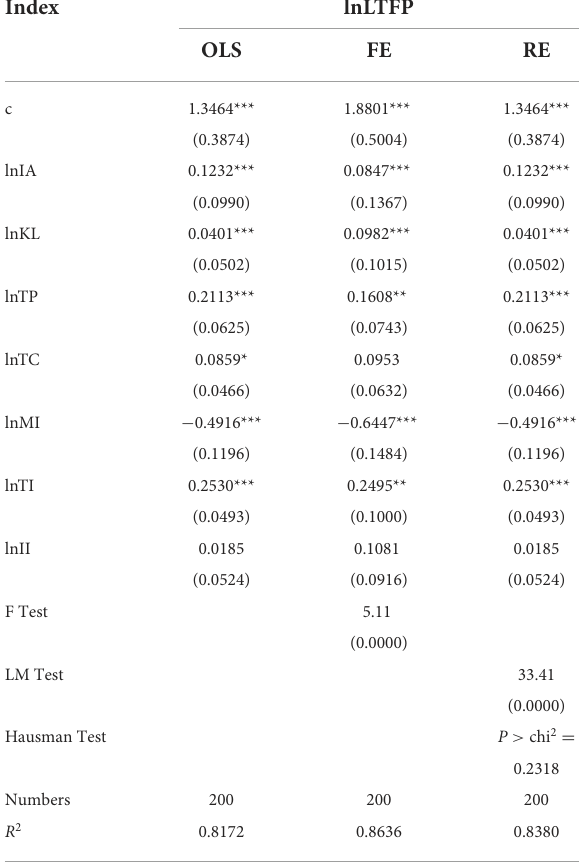
TABLE 6 Regression results of LUEE (lnLTFP, total factor